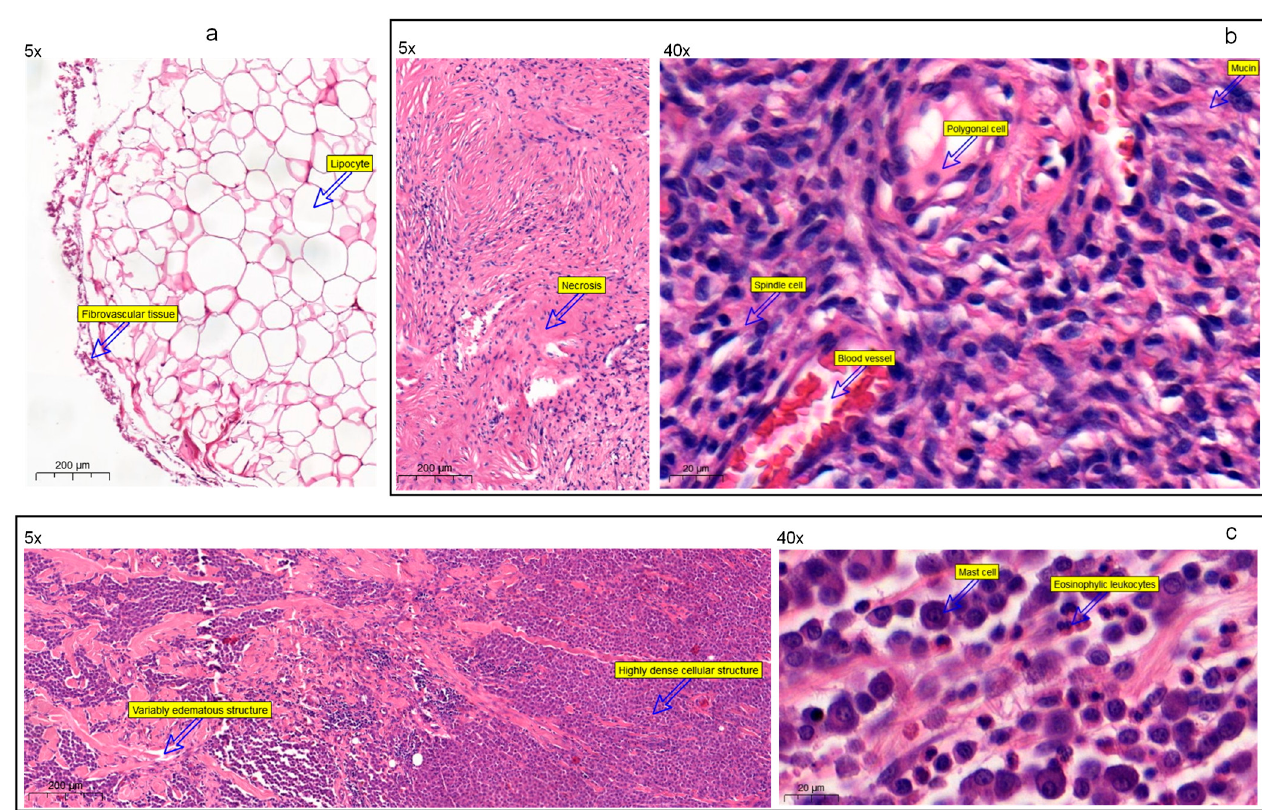
Figure 4. Histological characteristics of lipomas, sarcomas, and mast cell tumors; ( a ) lipoma in a dog, located in subcutis (sample# 20B0847, Table S1). It is a partly delineated, multilobular tumor with a dense cellular structure. The sample includes well-differentiated lipocytes of different sizes— with big fat cell vacuoles and flattened nuclei located in the periphery. The minimal amount of fibrovascular tissues supports tumor cells. ( b ) Soft tissue sarcoma in a dog, found in subcutis (sample# 20B0614, Table S1). It is a well-delineated, unencapsulated, multilobular spindle cell tumor; the cellularity varies from densely to scantly cellular. There are multifocal areas of edema, necrosis, and hemorrhages. Tumor cells are supported by a moderate amount of hyalinized collagen and occasional mucin deposits. Tumor cell morphology is highly variable, ranging from spindle cells— with a small amount of cytoplasm and elongated nucleus with small nucleoli, to polygonal cells—with a moderate amount of cytoplasm and a large, oval nucleus containing 2–4 moderately- to large-sized nucleoli. A prominent proliferation of small blood vessels is in the surrounding tissue. ( c ) Mast cell tumor in a dog, infiltrating dermis and subcutis (sample# 20B0446, Table S1). Wide, nonconfined